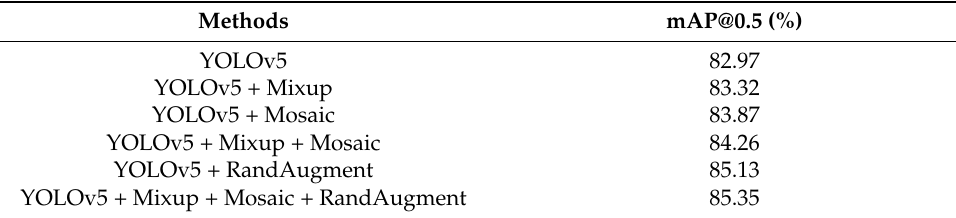
Table 1. Ablation study on data augmentation